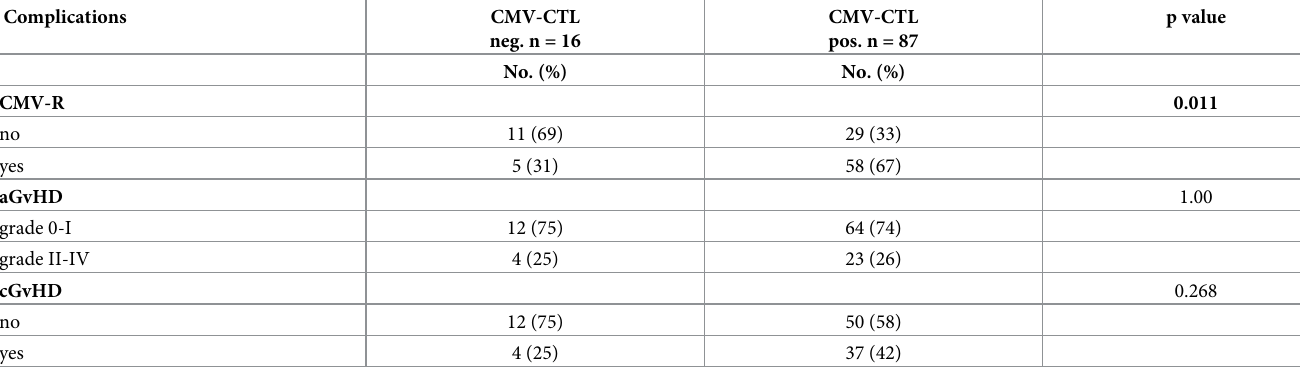
Fig 1. Immune reconstitution is dependent on the presence of CMV-CTLs. Course of CD3+ (left), CD8+ (middle) and CD4+ (right) T-cell reconstitution at 1, 2 or 3 months dependent on the presence (filled circles) or absence (open circles) of CMV-CTLs at the respective time points after allo-SCT in the CMV R+/D+ setting. The data points indicate mean ± standard error of the mean (SEM). Statistical analysis was performed using Mann-Whitney U test, P-values < 0.05 are indicated. https://doi.org/10.1371/journal.pone.0213739.g001 1, 2 and 5 years after allo-SCT was studied in univariate analysis along with other potential prognostic factors including patient age, gender, diagnosis, disease status, cyto-/molecular genetics, stem cell source, donor type, conditioning, GvHD prophylaxis, CMV-R, aGvHD or cGvHD ( Table 3 ). Table 3 summarizes parameters significantly correlated with OS, DFS, NRM and CIR in the univariate regression analysis. Factors not significant are shown in S1 Table. Univariate regression analysis of OS and DFS were performed by Cox-regression/cox pro- portional hazard regression analysis. Analysis of NRM and CIR were performed by the Fine and Gray test. The second column shows for each tested parameter two alternative variables. For the calculation of the hazard ratio, the first variable was set as 1.00. Abbreviations: OS, overall survival; DFS, disease free survival; NRM, non-relapse mortality; CIR, cumulative inci- dence of relapse; HR, hazard ratio; CI, confidence interval; CSA, Cyclosporine A; MTX, meth- otrexate; MMF, mycophenolate mofetil; CMV-R, CMV reactivation; aGvHD, acute graft- versus-host disease; cGvHD: chronic GvHD. The OS was not affected by the presence of CMV-CTLs at 3 months after allo-SCT, but OS at 2 years was significantly longer in patients receiving matched donor grafts (p = 0.014) or at 5 years in patients receiving GvHD-prophylaxis with CsA/MTX (p = 0.038). The OS at 1, 2 Table 2. Complications after